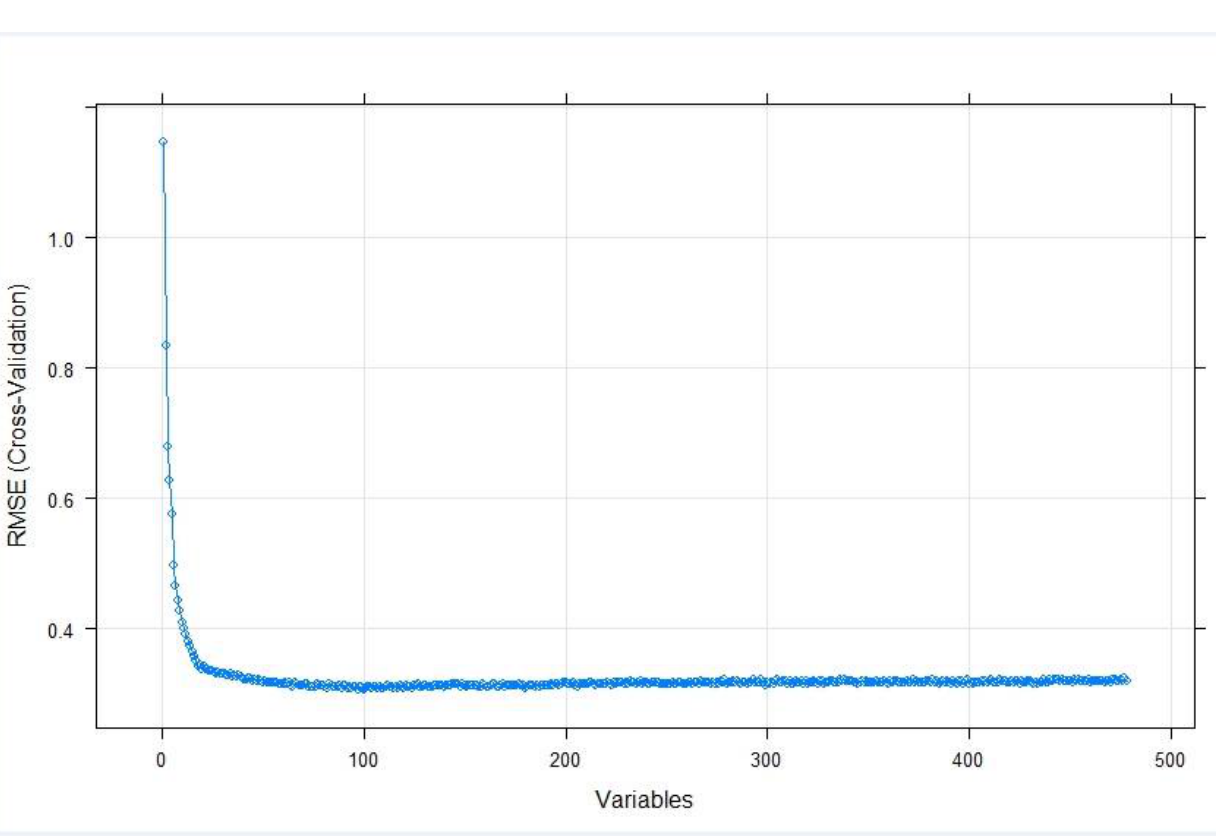
Figure 2. Significant Variables Using the Random Forest Boruta Method.